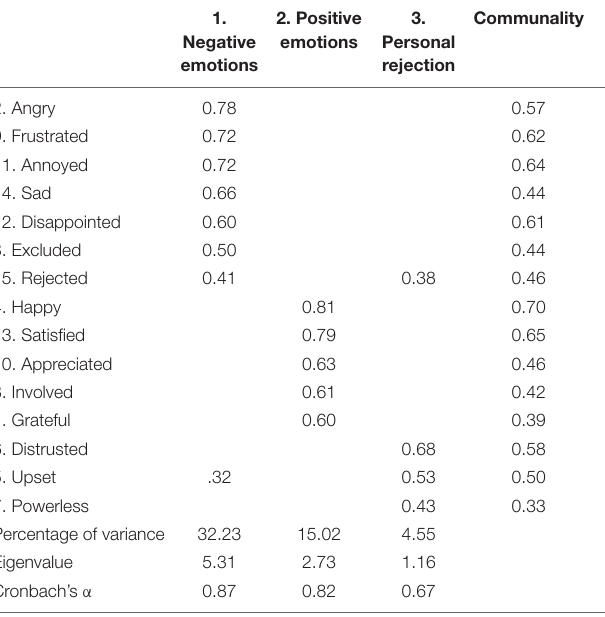
TABLE 2 | Factor loadings based on an exploratory factor analysis with a principal axis factoring and direct oblimin rotation on 15 items measuring emotions and affective reactions ( N =